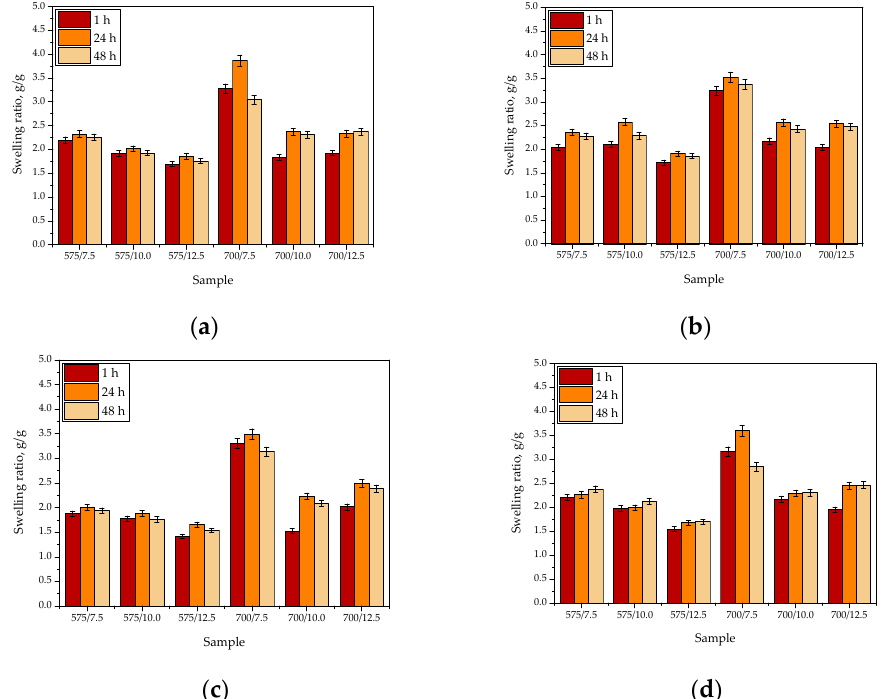
Figure 18. Results of investigations on sorption properties of hydrogels in distilled water ( a ), SBF ( b ), ( b ), Ringer liquid ( c ), and hemoglobin ( d ). Ringer liquid ( c ), and hemoglobin ( d